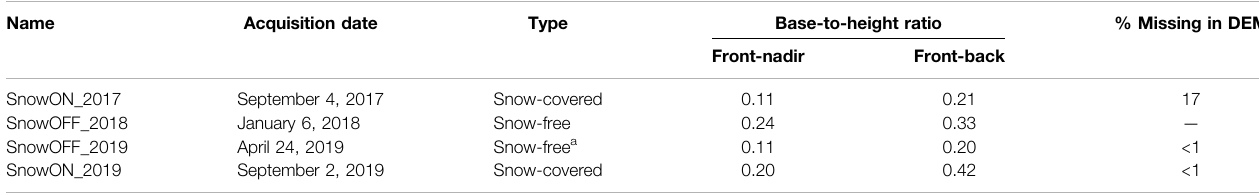
TABLE 1 | The basic information regarding each DEM date referred to in the